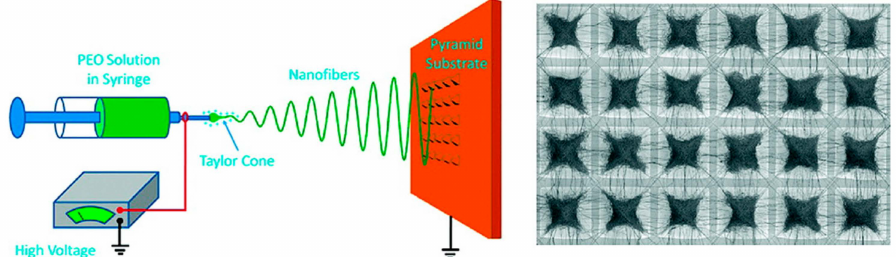
Figure 4. A representation of the electrospinning technique used by Ding and colleagues for the controlled deposition of fibers on a patterned collector. Adapted with permission from [35], American Chemical Society,